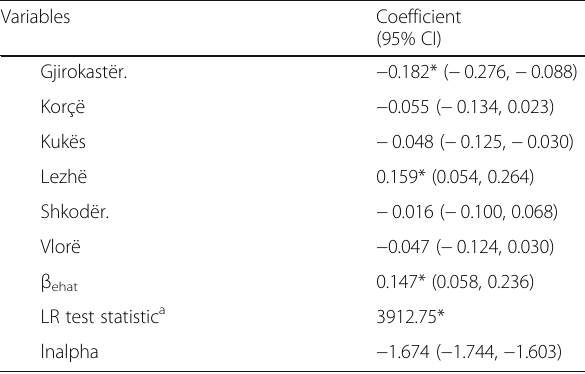
Table 4 Regression results for frequency of smoking ( N = 3277) Variables